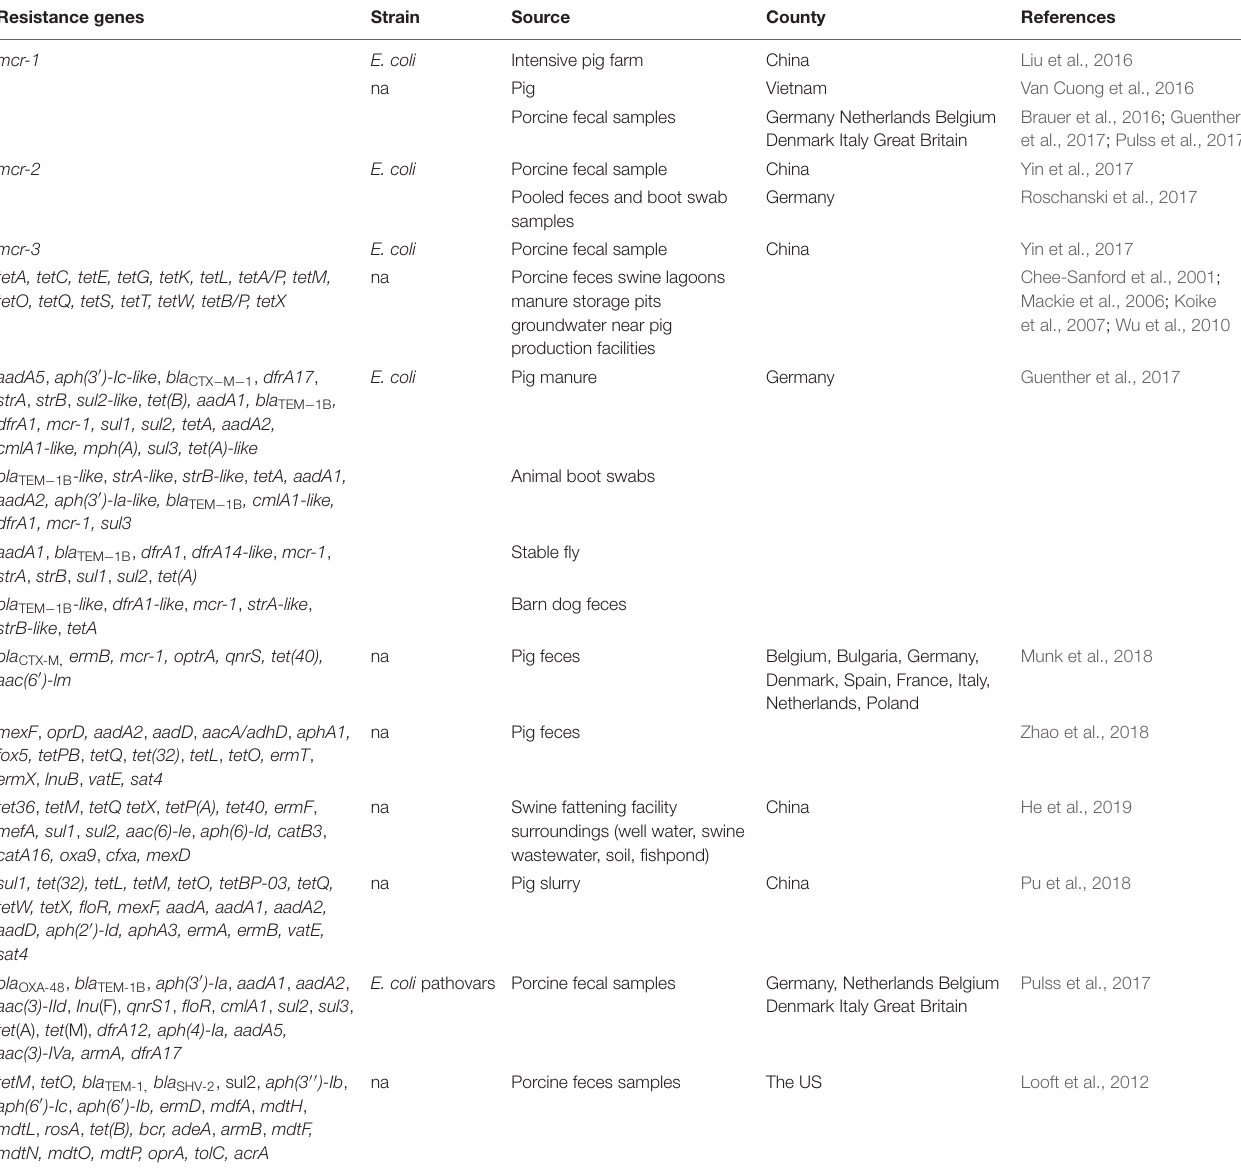
TABLE 3 | Antibiotic resistance genes in